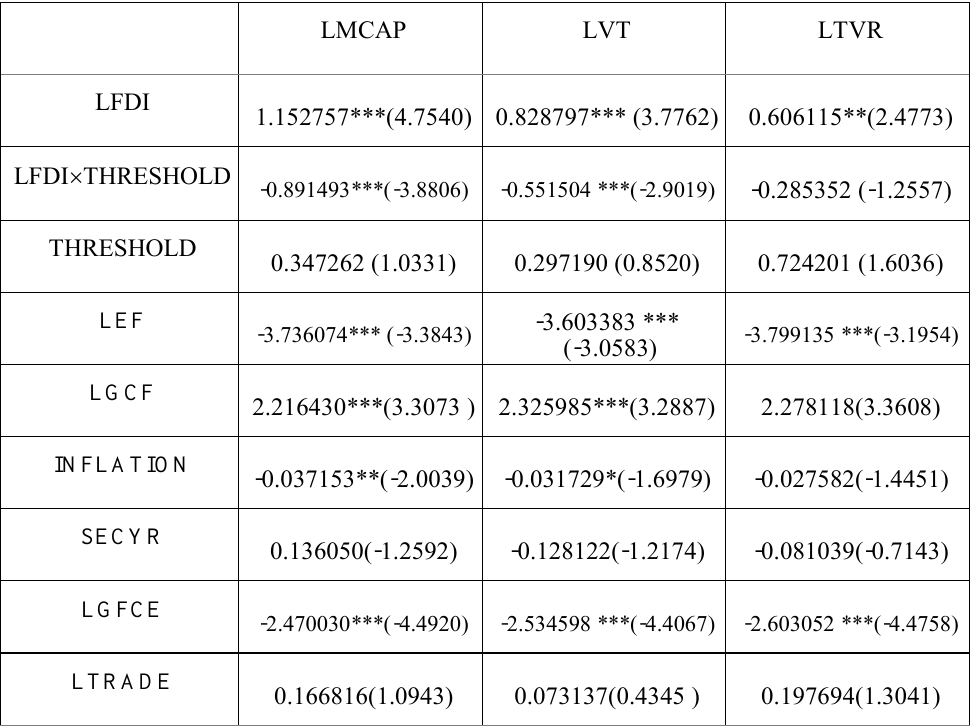
Table10.Result of regression of equation